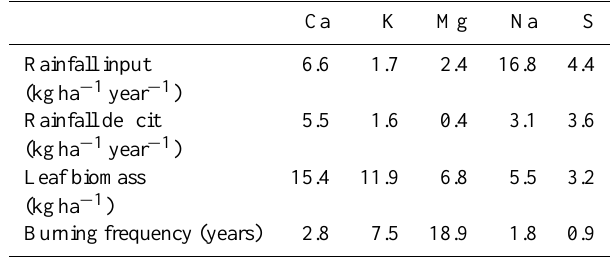
Table 10. Burning frequency required for depletion of common elements in groundwater. Rainfall deficit from Table 5 (Group A groundwater); leaf biomass values for Eucalyptus camaldulensis from Briggs and Maher (1983) and Fekeima et al. (2012); see text for